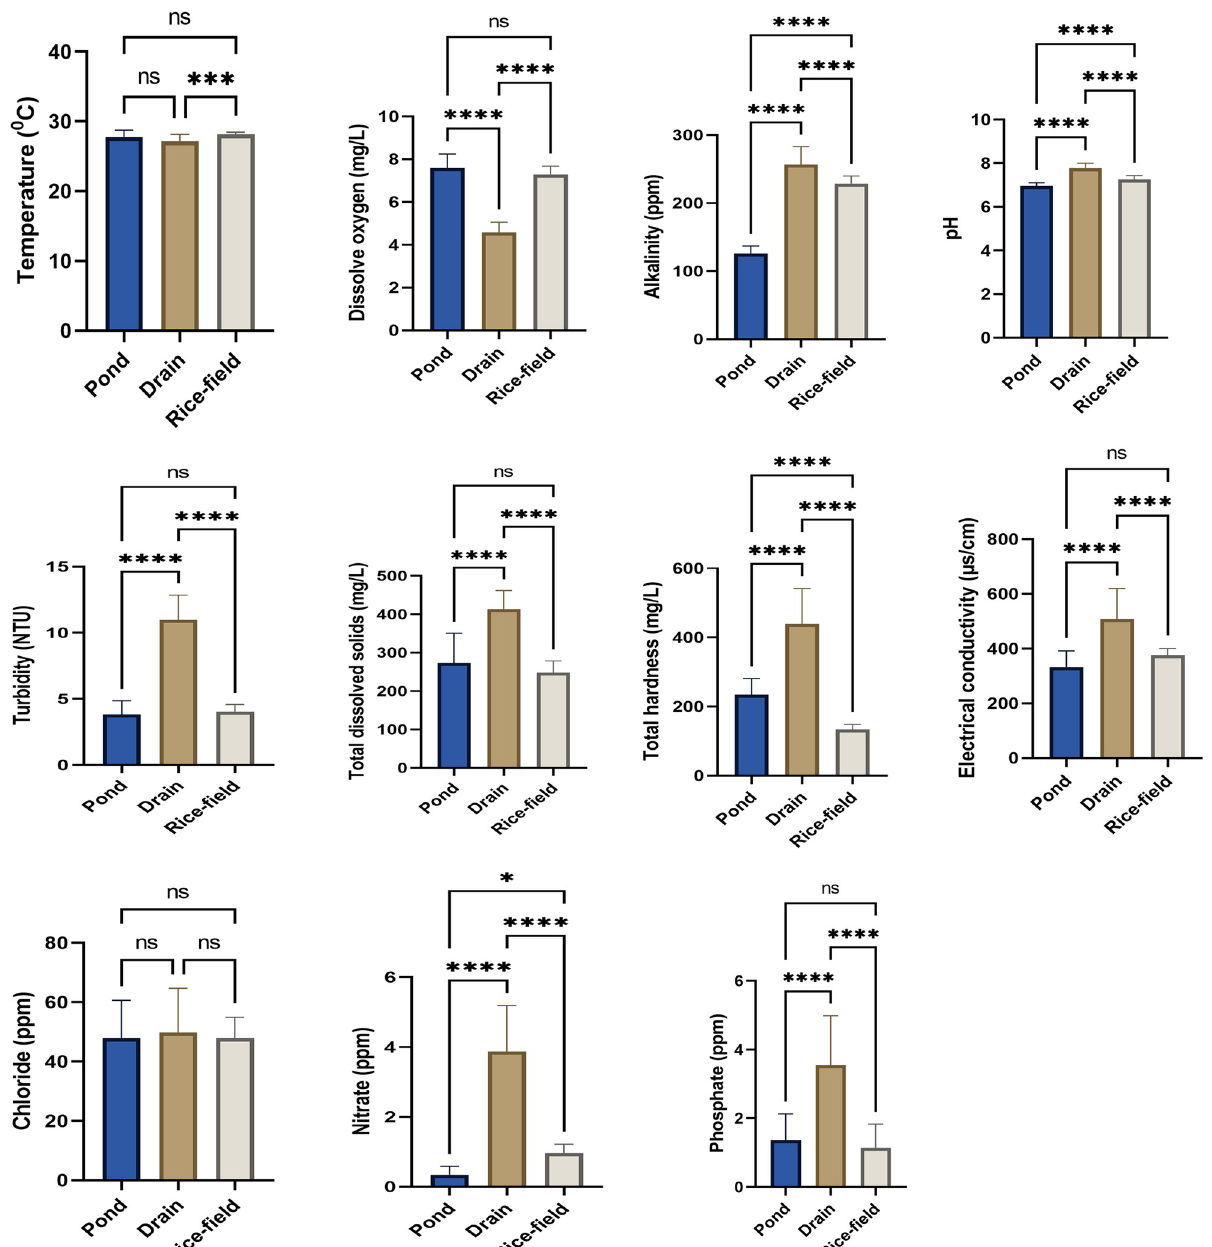
Fig 4. Physico-chemical parameters of different habitat types during post-monsoon season. An asterisk above given bar indicates significant difference. ‘ ���� ’ indicates p < 0.0001, ‘ ��� ’ indicates p < 0.001, ‘ �� ’ indicates p < 0.01, ‘ns’ indicates p > 0.05. alkalinity (0.84), whereas negative association of F1 was found with D.O (-0.93) & L.D (-0.55). F2 showed positive association with temperature (0.70) & alkalinity (0.36) and negative associ- ation with L.D (-0.67) & conductivity (-0.43) (S7A–S7C Table). During post-monsoon season F1 and F2 together contributed 73.83% of the total variance (60.59% and 13.24% variation explained by F1 and F2 respectively) (Fig 6C). Here major contributing factors for F1 were tur- bidity (12.24%), nitrate (11.90%), D.O (11.63%) & hardness (10.07%). The major factors